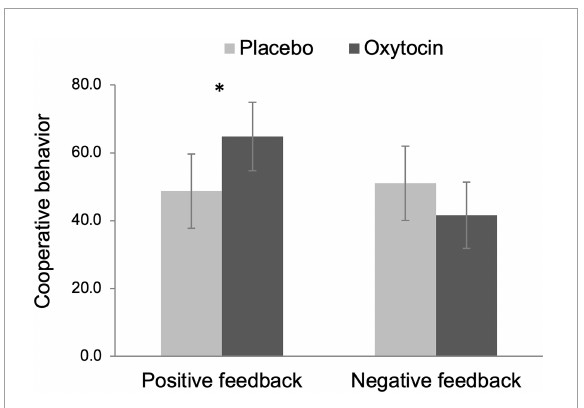
FIGURE3 Cooperative behavior (i.e., the amount of money participants put in the common pot during the public goods provision task) as a function of intranasal spray (placebo vs. oxytocin) in each feedback condition. The data were rank-transformed to reduce skewness. Error bars indicate 95% confidence intervals. ∗ p <